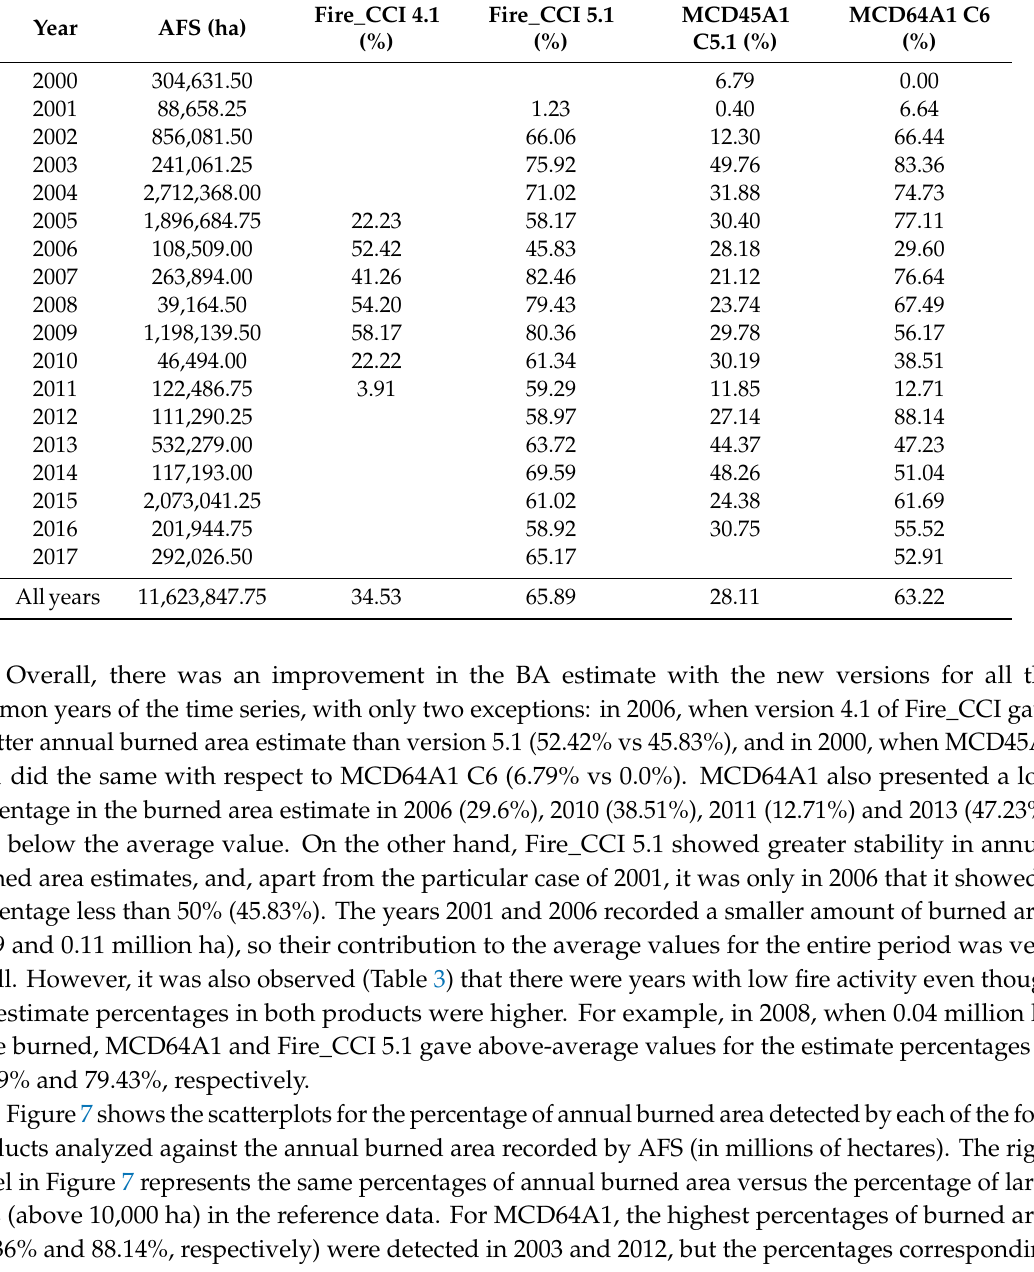
Table 3. Annual Reference BA (AFS, Fort Wainwright, AK, USA) and estimates (%) of the four